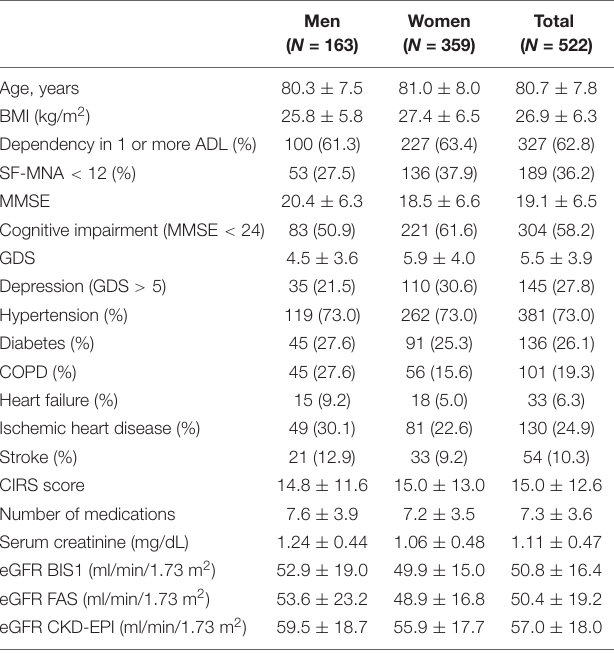
TABLE 1 | General and clinical characteristics of the NH residents recruited in the present